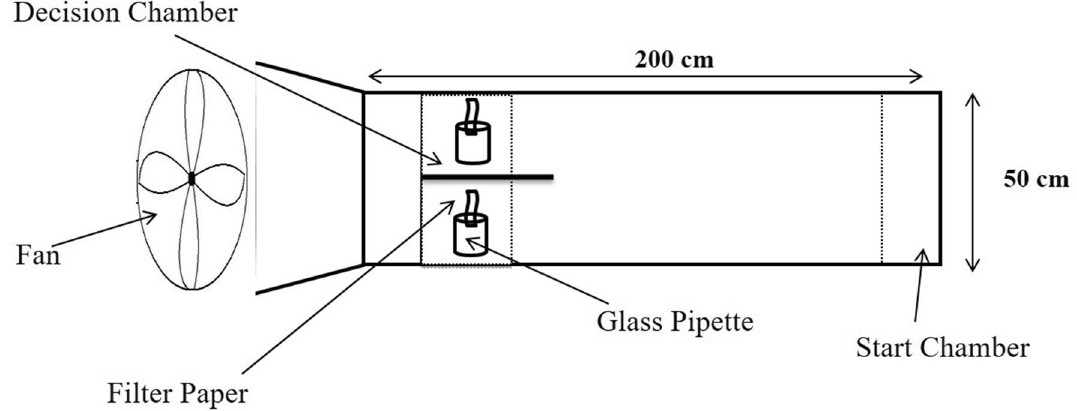
Figure 1. Schematic view of the flight tunnel (top view). Individual wasps were introduced in the start chamber and observed choosing between the two odors displayed on filter papers in the decision chambers for 15 min.